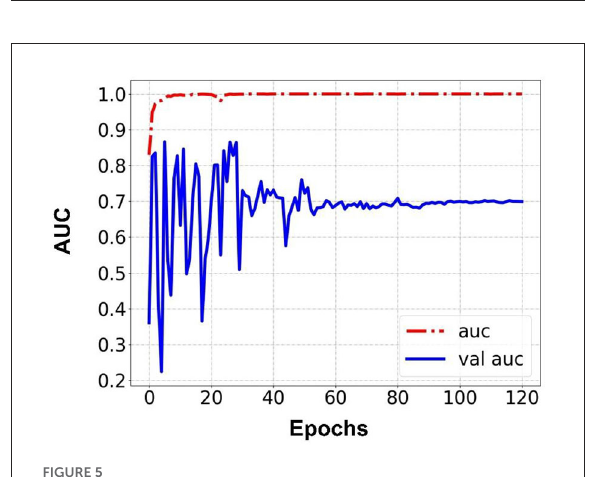
FIGURE5 AUC for Task 1 in an image.